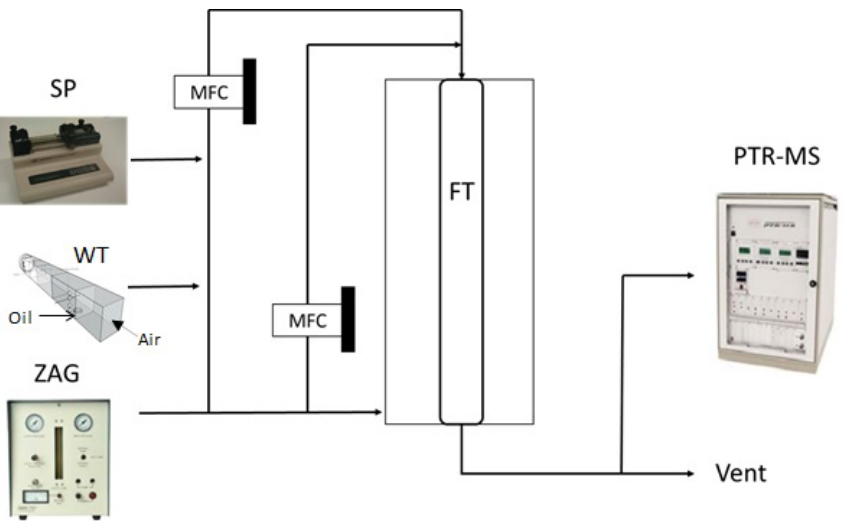
Figure 1. Schematic of the flow tube (FT) used to mix and dilute the n -alkanes coming from the syringe pump (SP) and wind tunnel (WT) with zero air produced by a generator (ZAG), followed by analysis using proton-transfer-reaction mass spectrometry